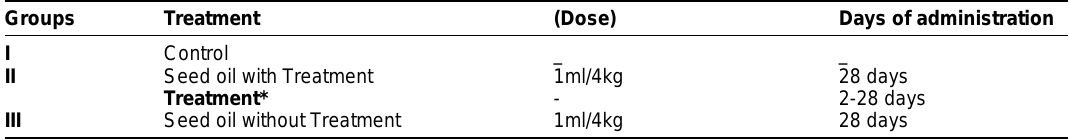
Table-1. Experimental design for subacute toxicity of Jatropha curcas seed oil and its therapeutic module in goats (n=3 per group)